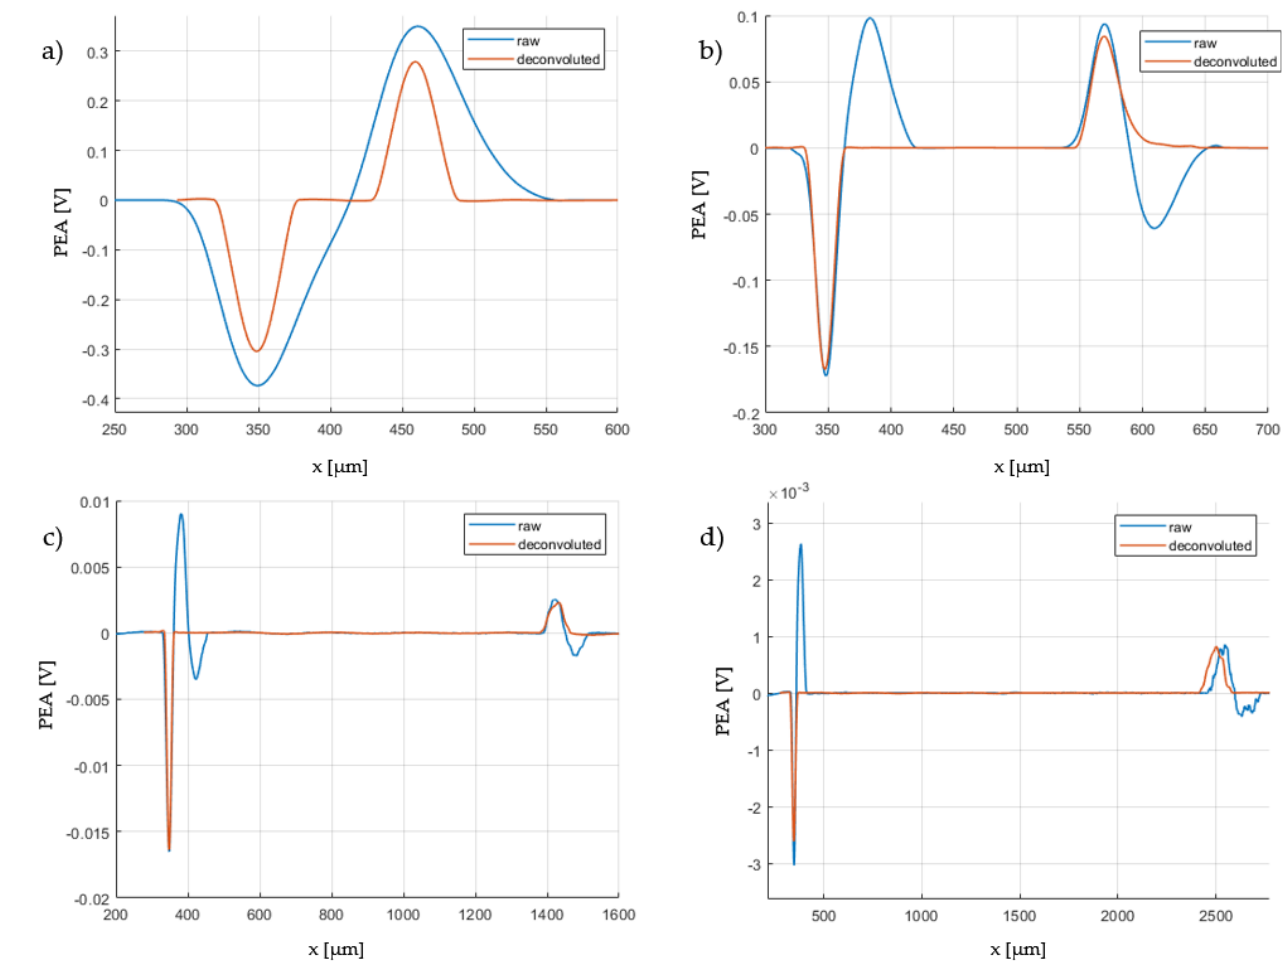
Figure 7. Space charge profile in LDPE measured for samples with different thickness, sensor d s = 9 µm, UHVDC U = 2 kV, raw signal, and after deconvolution, pulser t r = 1 ns t w = 5 ns, LDPE thickness: ( a ) d = 0.1 mm, ( b ) d = 0.2 mm, ( c ) d = 1 mm, ( d ) d = 2 mm.